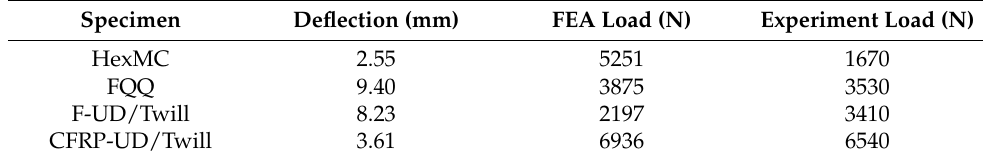
Table 8. FEA simulation values showing mid-span deflection and resulting loads.